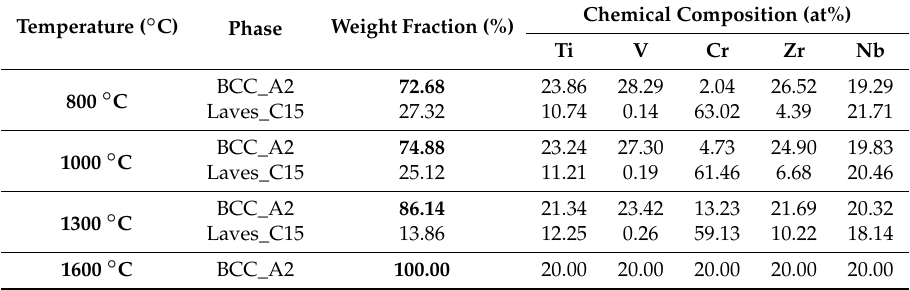
Table 1. Model prediction of chemical composition of every phase in equilibrium at the designated